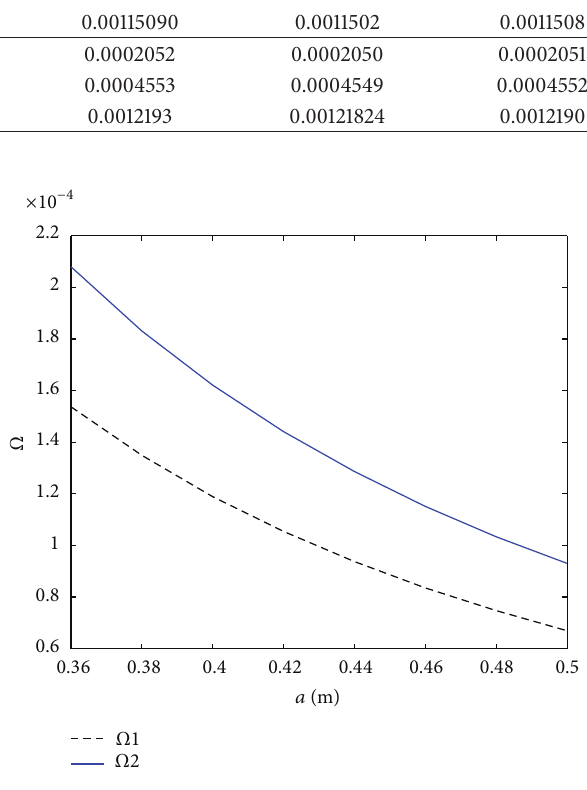
Figure 9: Variation of the second mode natural frequency with the radius of the plate for different layups and clamped-clamped boundary condition ( 𝑏 = 0.05 m and ℎ 𝑐 = 0.001 m).